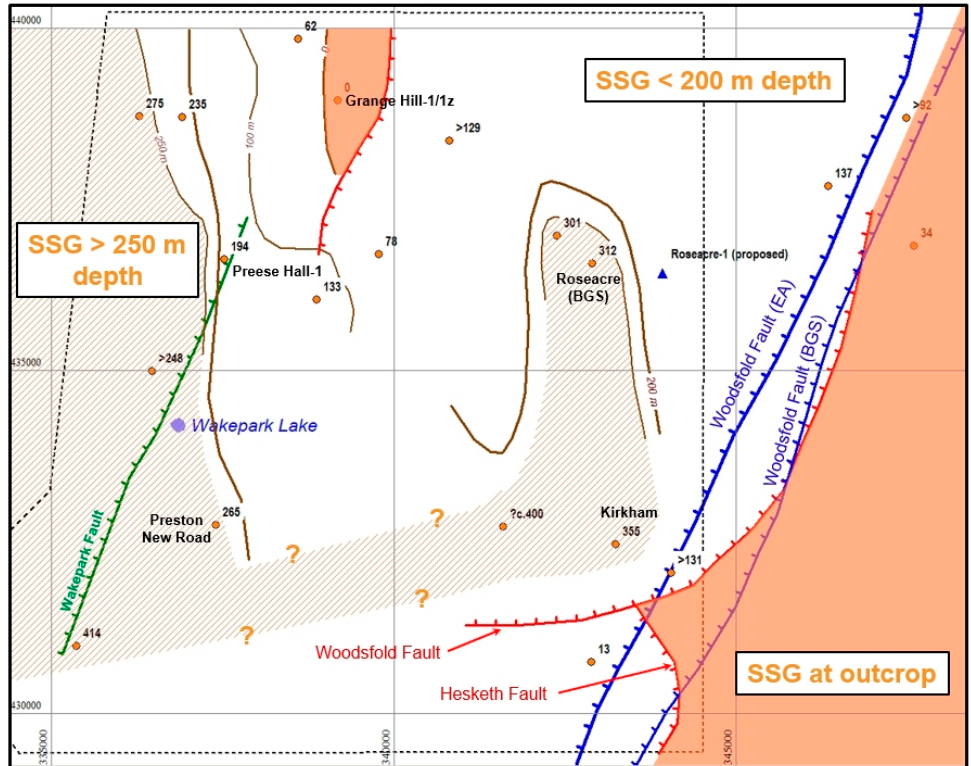
Figure 6. The Fylde, Lancashire. The Sherwood Sandstone Group (SSG) is at outcrop east of the Woodsfold and Hesketh Faults (red) and in a small upfaulted block where Grange Hill-1/1z was drilled. Contours on the top SSG are shown at 0, 100, 200 and 250 m. The cross-hatched area shows where the SSG is greater than 250 m deep. The dashed outline is the area covered by the Bowland-12 3D seismic survey. Two prior versions of the Woodsfold Fault are shown in blue. Roseacre-1 (blue triangle) was Cuadrilla’s proposed well at Roseacre Wood, distinct from the 500 m deep Roseacre monitoring well drilled by the BGS. Numbers attached to boreholes (orange dots) indicate depth in metres below sea level to the top of the SSG.